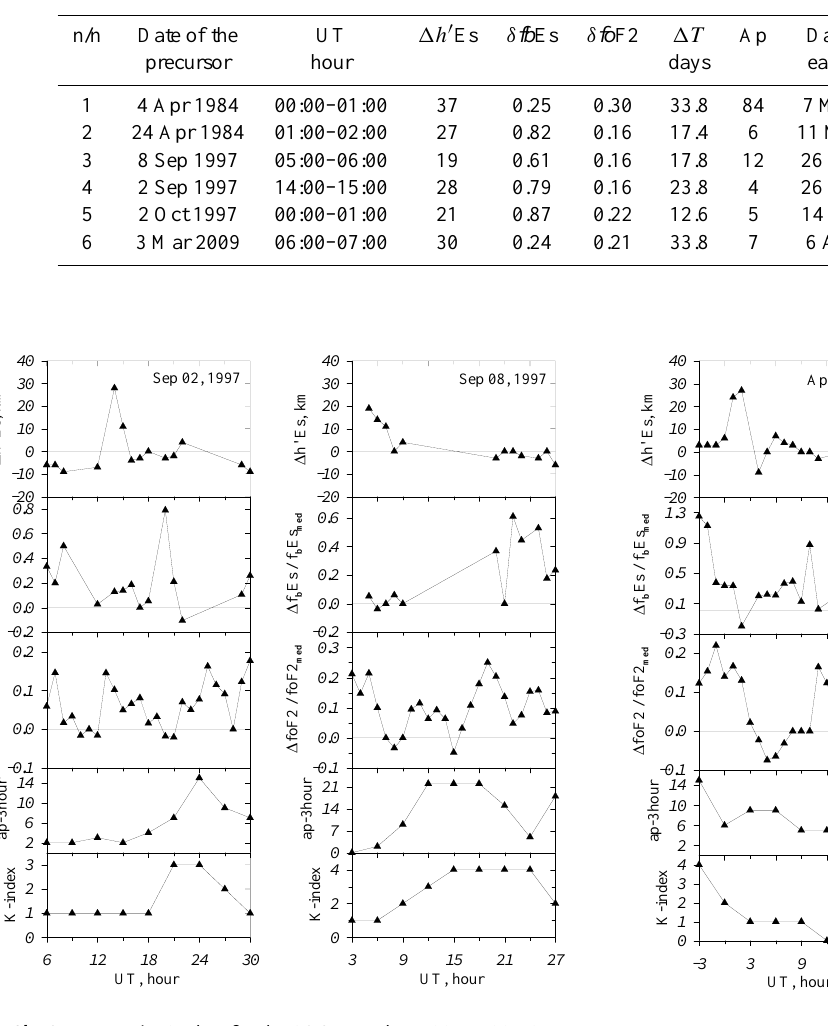
Fig. 2c. Same as Fig. 2a, but for the 11 May 1984 (left panel) and